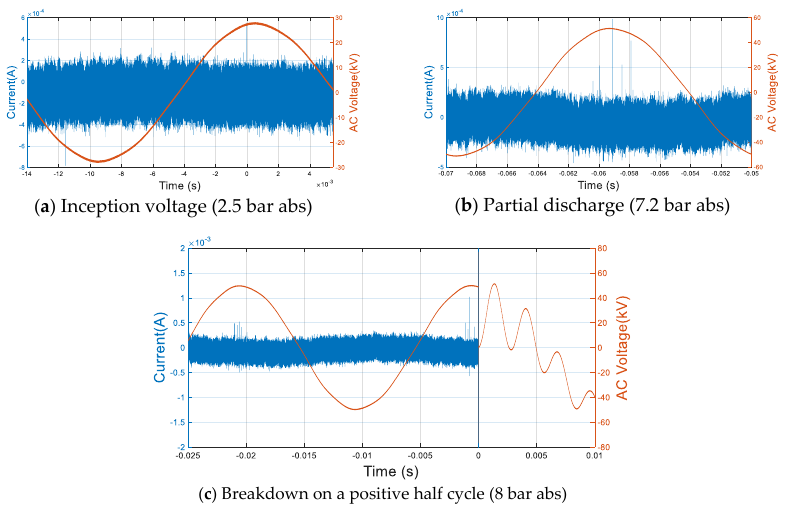
Figure 9. Voltage-current waveform for measuring inception voltage, partial discharge, and breakdown voltages (4%Novec TM 4710/96%CO 2 ).